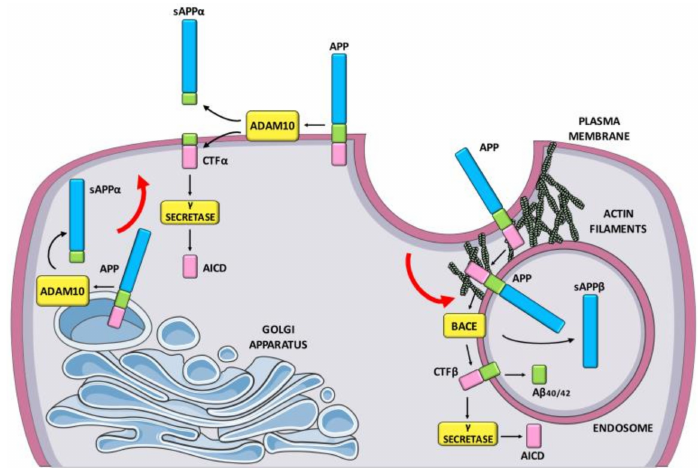
Figure 1. Schematic representation of β -amyloid precursor protein (APP) processing. The vast majority of BACE1 cleavage of APP occurs into BACE1-containing acidic organelles via clathrin-dependent endocytosis. The subsequent γ -secretase activity determines the release of A β . Alternatively, APP can undergo a non-amyloidogenic pathway that involves the α -secretase ADAM10 and occurs largely on the plasma membrane and in the trans-Golgi network. Red arrow, exocytosis / endocytosis pathways; black arrows, enzymatic cleavage of